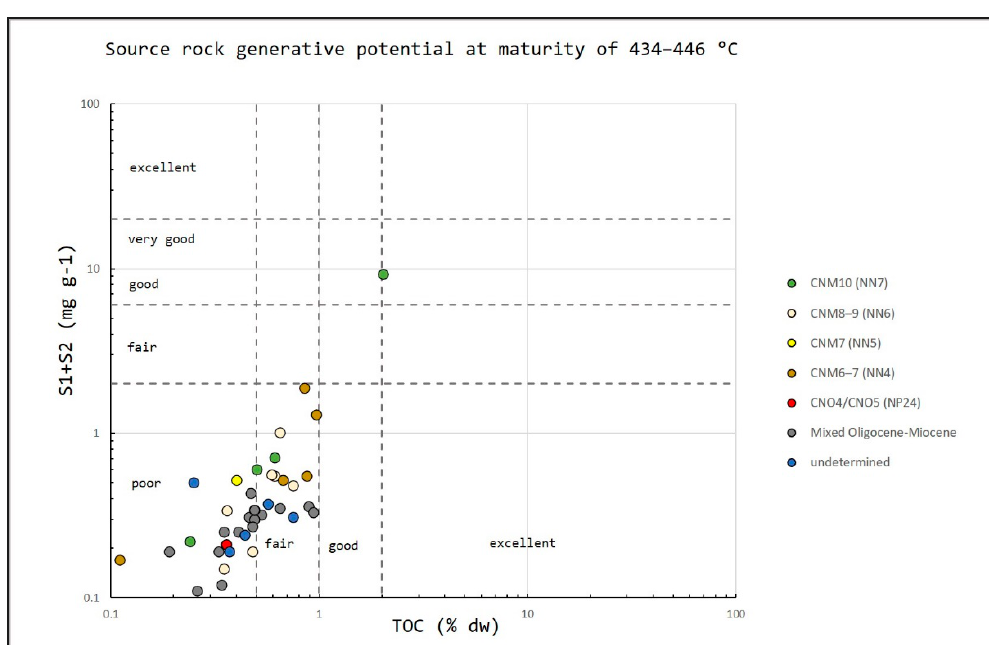
Figure 8. HI vs. Tmax plot showing, in parallel, the kerogen-type curves and maturity levels along with the upper- and lower-vitrinite reflectance thresholds (Ro) for oil generation. Note the distinct position of the sample LEV1GC 4–6 clast 1 (CNM10 biozone), which approaches the type II kerogen curve.